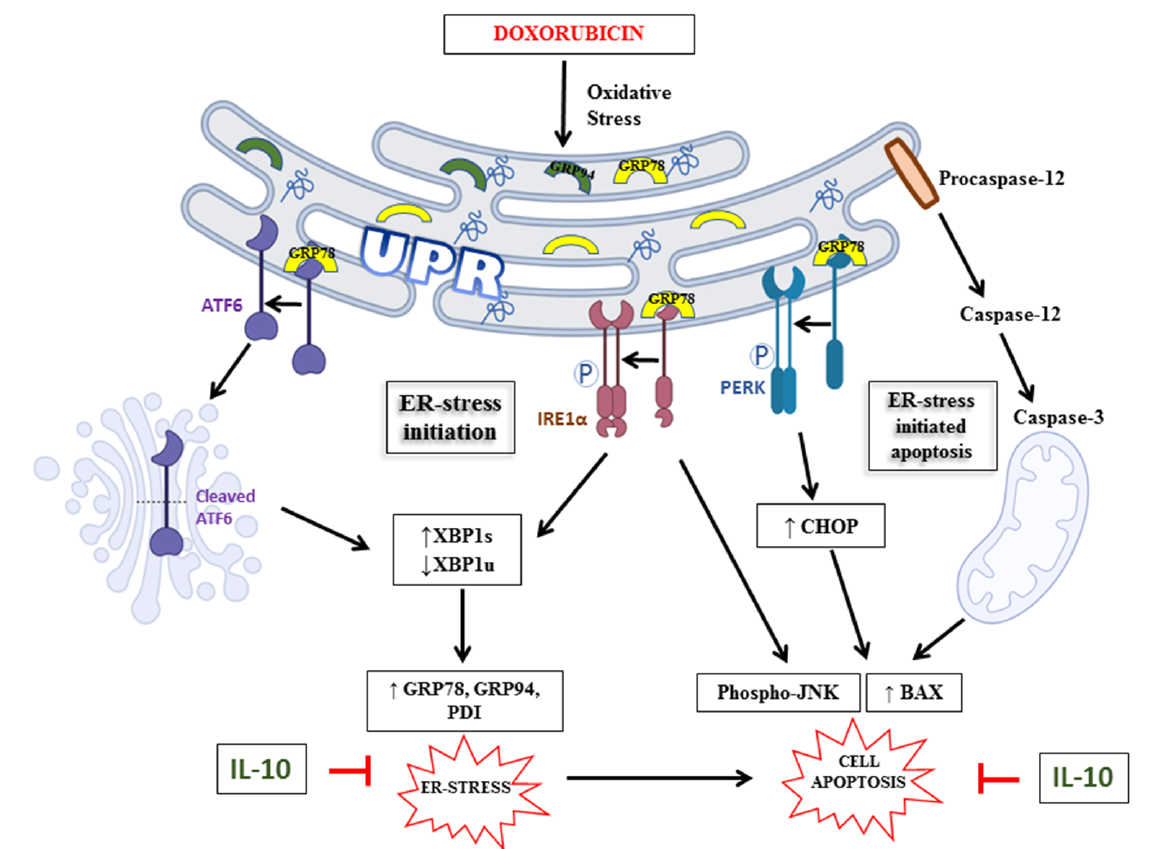
Figure 8. An overview of Dox-induced ER stress and apoptosis as well as its mitigation by IL-10. Dox-induced oxidative stress can disturb the ER homeostasis leading to the accumulation of unfolded and/or misfolded proteins. This unfolded protein response (UPR) then leads to the activation of UPR transducers: ATF6, IRE1 α , and PERK via dissociation of GRP78. ATF6 cleavage in the Golgi body increases XBP1s and inhibits XBP1u, followed by an upregulation of ER stress markers (GRP78, GRP94, and PDI). Dox also initiates an activation of procaspase-12, which is known to activate caspase-3, BAX, and apoptosis through mitochondria. The exogenous administration of IL-10, one hour prior to the exposure of cardiomyocytes to Dox for 24 h, was found to be effective in suppressing the expressions of ER stress markers (GRP78, GRP94, PDI, and XBP1), as well as reducing the activation of procaspase-12, JNK phosphorylation, Bax activation, and cell death. ↑ : upregulation; ↓ : downregulation.